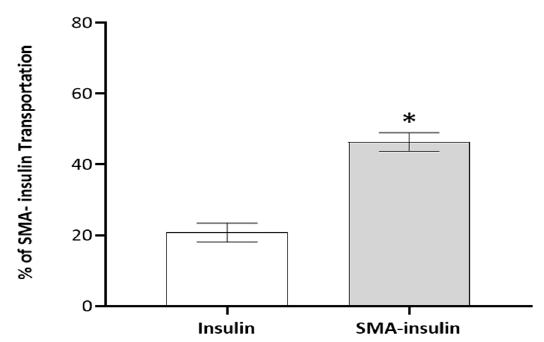
Figure 2. SMA-insulin micelles transportation across in vitro model of the intestinal epithelium. The differentiated Caco-2 cell monolayers were incubated with insulin and SMA-insulin solutions (100 μ M) to the apical surface for 3 h. Data are expressed as means ± SEM ( n = 4). % of total transport of insulin was analyzed using a t -test. * indicates statistical difference from the insulin group, p < 0.05.